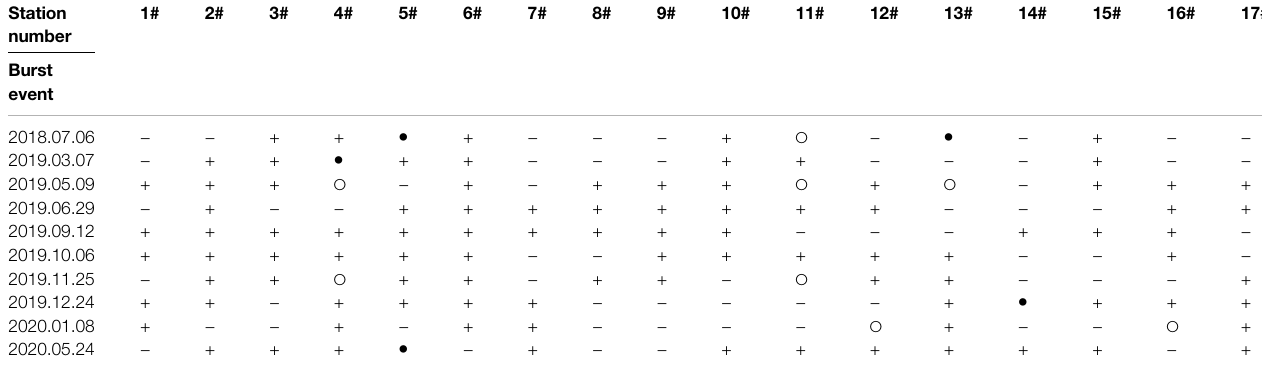
TABLE 4 | P-wave fi rst motion of previous burst events.